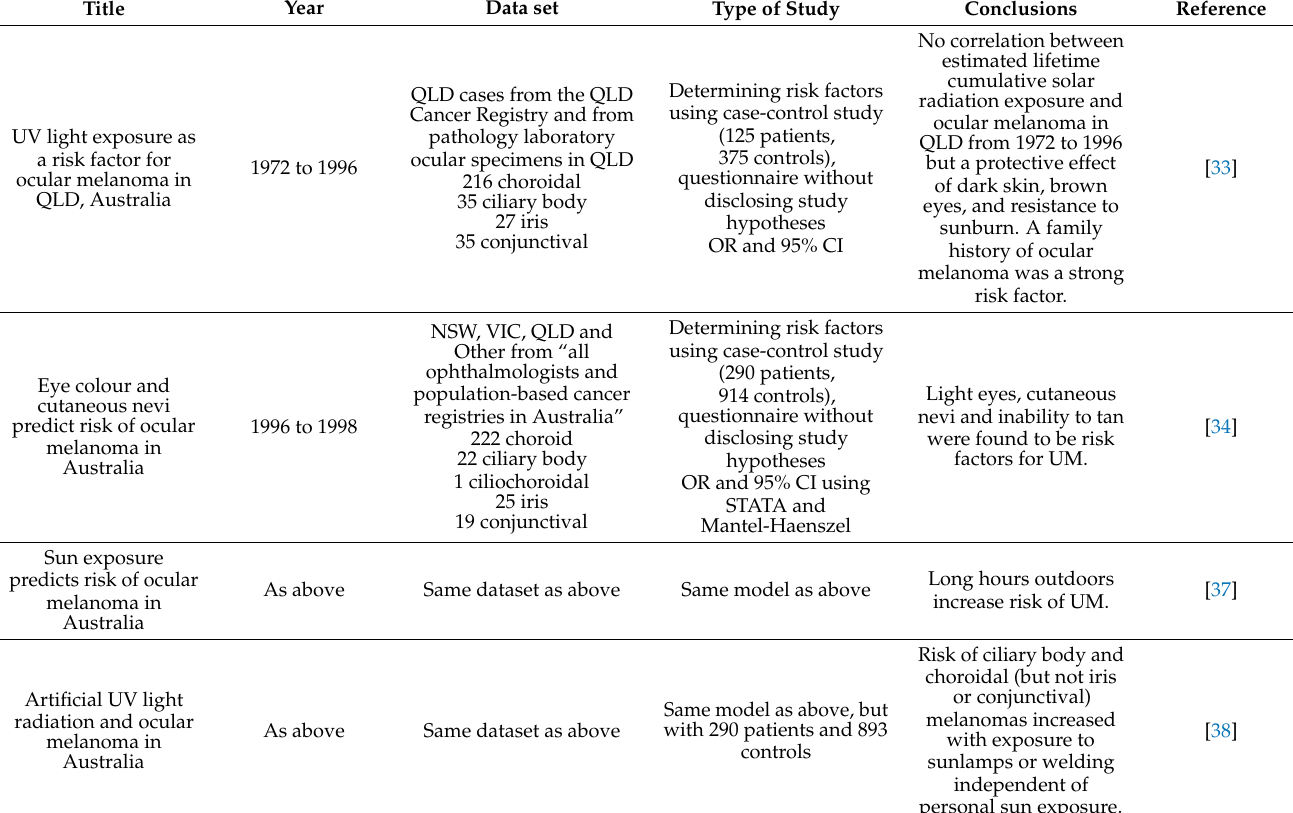
Table 2. Studies on UM in Australian